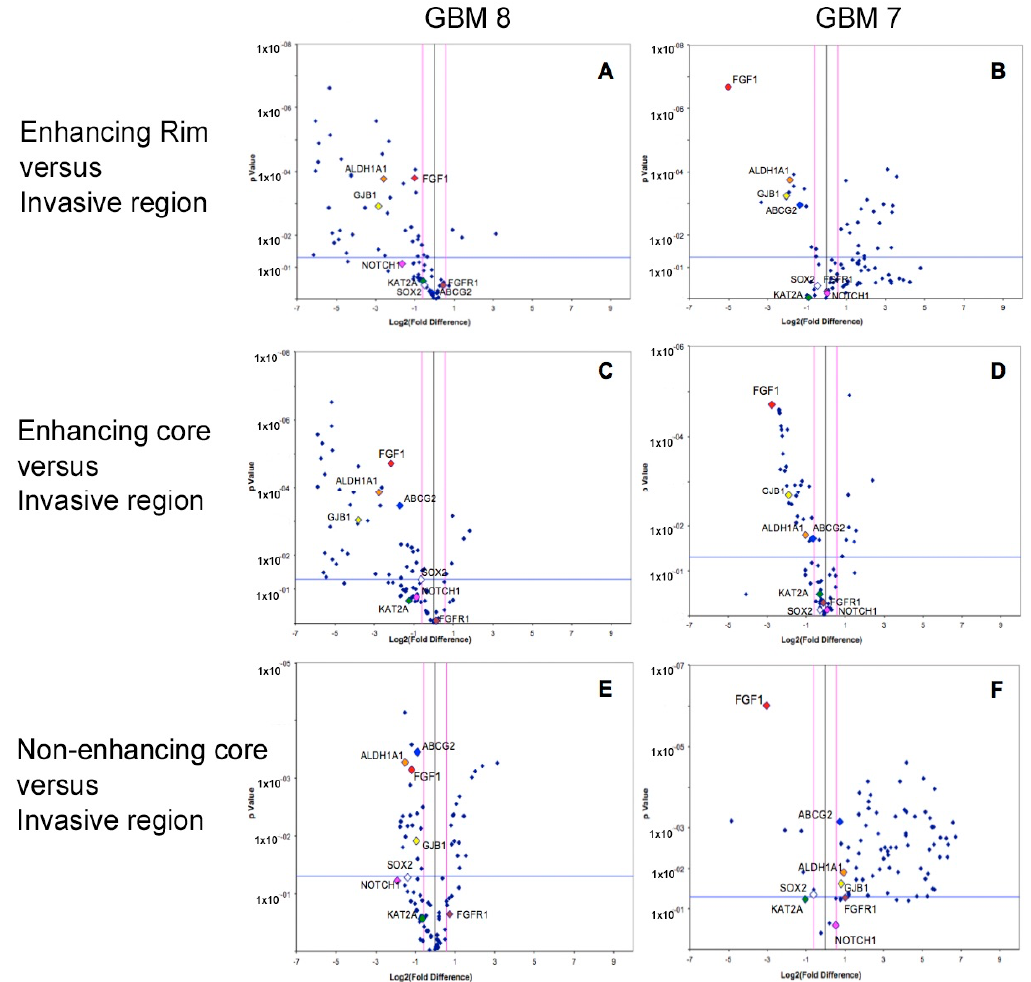
Figure 5. The GBM invasive margin is characterized by a unique stem cell transcriptomic profile. Array PCR studies of known stem related markers (including cell cycle regulators, chromosome and chromatin regulators, self-renewal and differentiation markers) demonstrated distinct stem cell expression profiles within different spatial regions of two primary patient GBMs (GBM 7, GBM 8). The specific stem cell markers ALDH1A , ABCG2, and FGF1 were consistently and significantly over-expressed (all p values < 0.05) in the invasive margin of GBM when compared to ( A , B ) enhancing rim, ( C , D ) enhancing core and ( E , F ) non-enhancing core tumour regions. The gap junction protein gene GJB1 was also consistently over-expressed in the invasive region. Other stem cell markers had varied expression between tumour regions on PCR, with expression of an average of 39 markers varying significantly between regions. Neurogenic locus notch homolog protein 1 (NOTCH1), lysine acetyltransferase 2A (KAT2A); sex-determining region Y-box 2 (SOX2); fibroblast growth factor receptor (FGFR1);